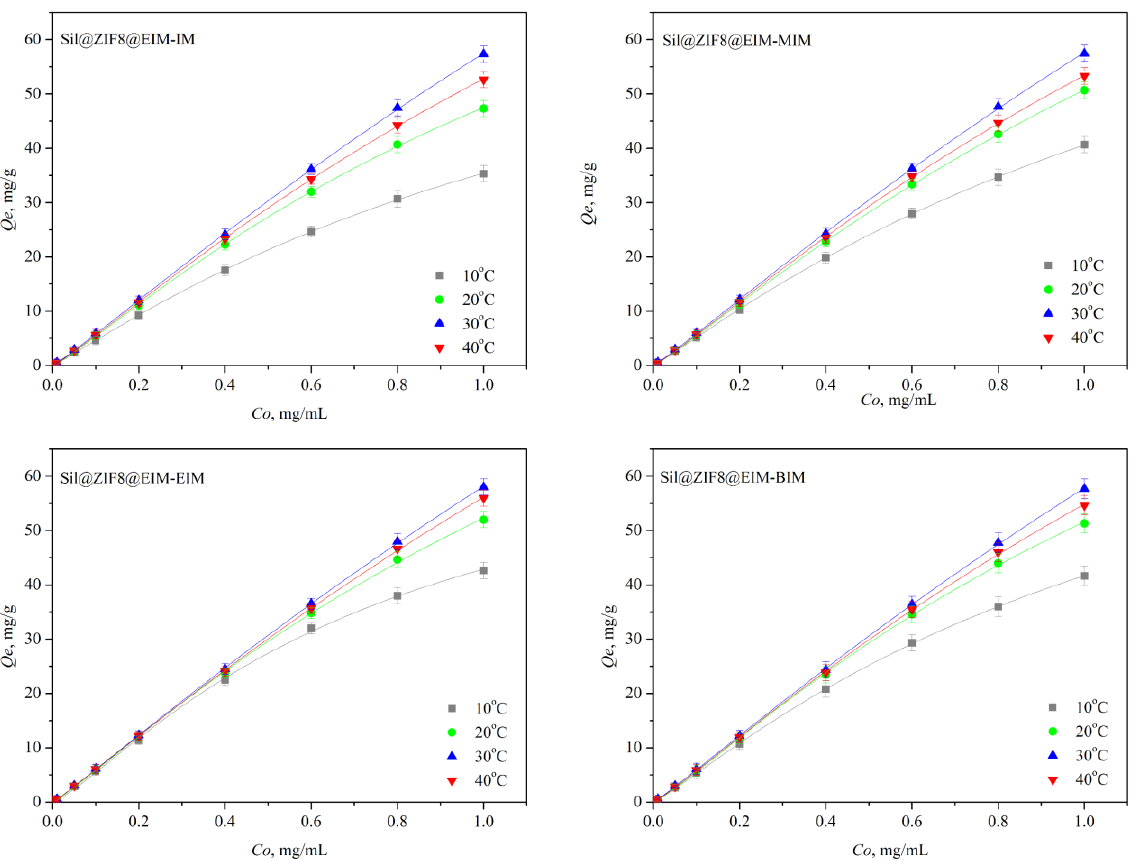
Figure 5. The adsorption isothermal relationships between C 0 and Q e of (+)-catechin on four